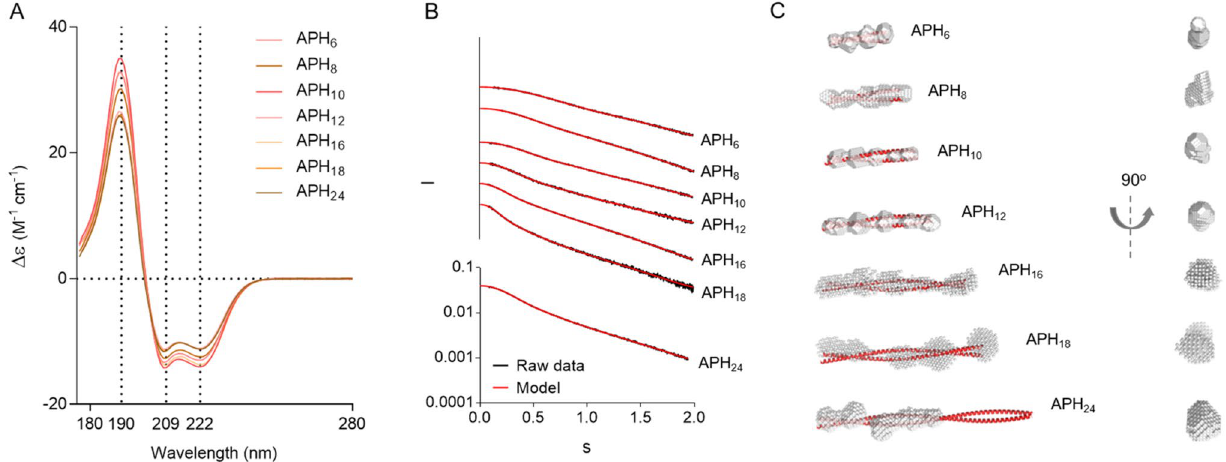
Figure 2. Biophysical characterization of APH variants. Structure of each of the APH spacers was characterized using SR-CD ( A ) and SAXS ( B , C ). ( A ) Shows the SR-CD spectra of spacers with four to twenty four heptad repeats measured at 25 °C. Raw SAXS data (shown in black) and data back predicted from the ab initio models (shown in red) is summarized in ( B ). Ab initio SAXS models of all APH variants are shown in white with the